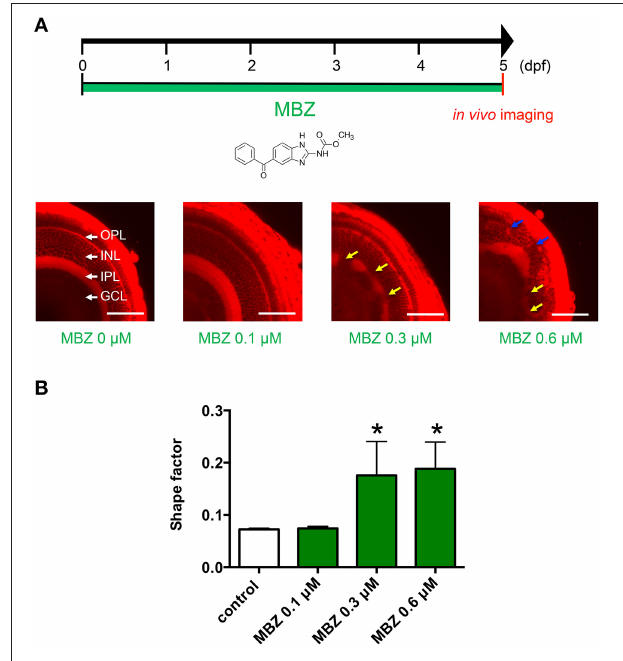
FIGURE 1 | MBZ caused developmental toxicity in the zebrafish retina. (A) Zebrafish were treated with MBZ from 0 to 5dpf at the indicated concentration. At 5dpf, zebrafish were stained with ZMA462 and the retinas were imaged in vivo . The GCL, IPL, INL, and OPL are indicated by white arrows. The malformations in the IPL and OPL caused by MBZ are indicated by yellow and blue arrows, respectively. Scale bar: 50 µ m. (B) Quantitative analysis of the developmental toxicity of MBZ in the zebrafish retina. The shape of the IPL in each zebrafish were quantified using the shape factor. n = 8 for control, n = 3 for each concentration, * p < 0.05 compared with